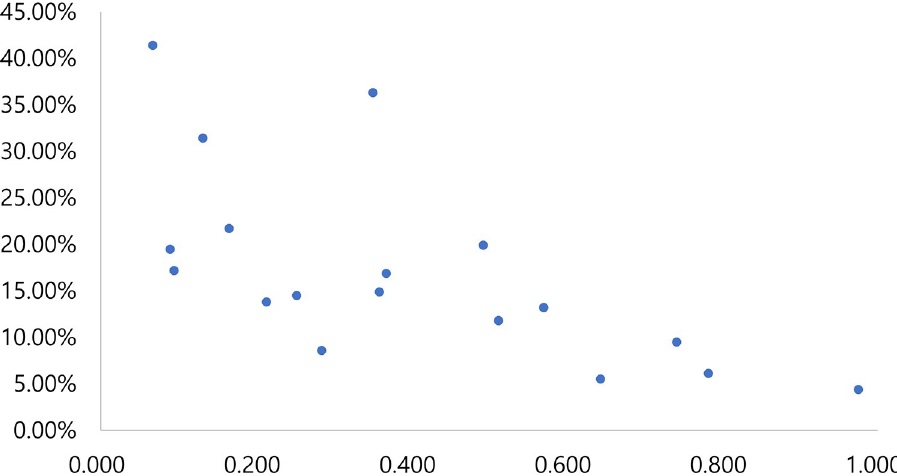
Fig 6. Correlation between Theil L index and coverage of an improved household latrine (x-axis: Theil L index; y-axis: Coverage, the authors generated the map).